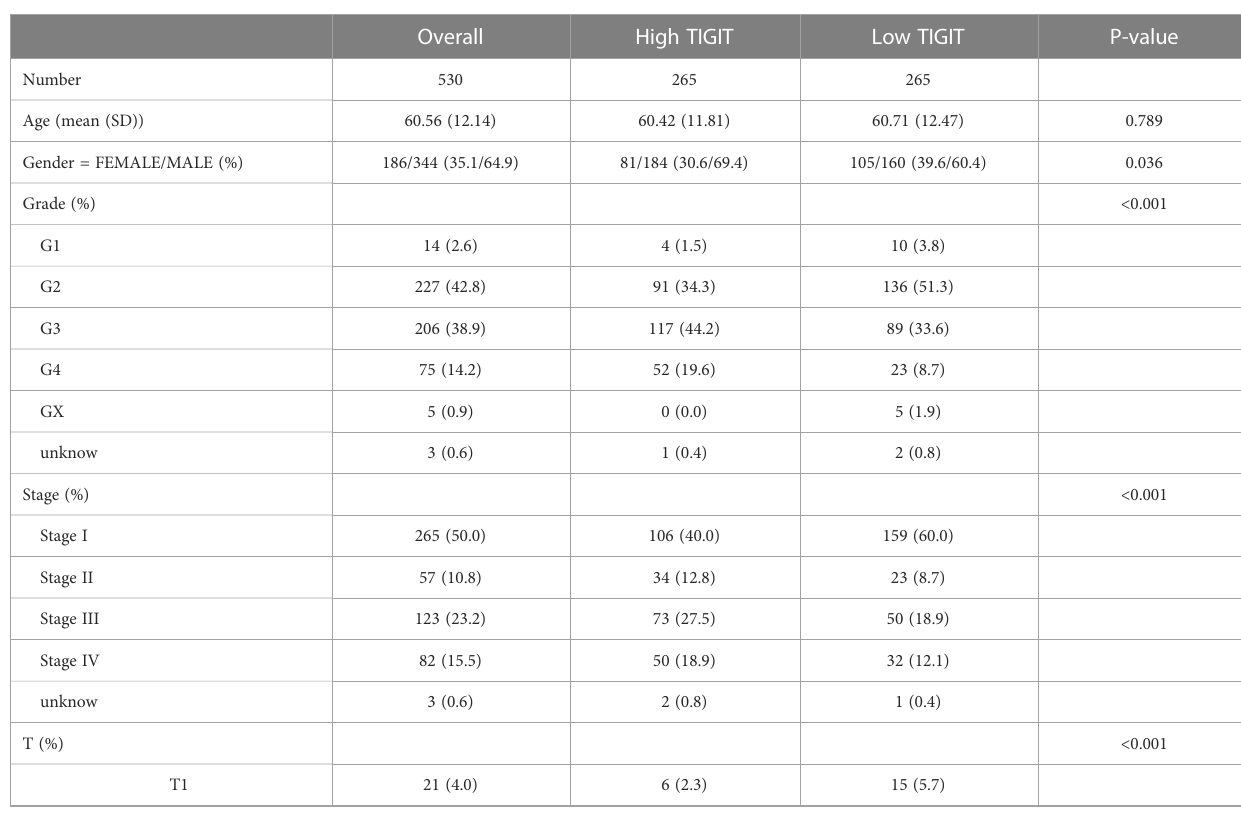
TABLE 1 Detailed clinicopathological characteristics of the KIRC patients.